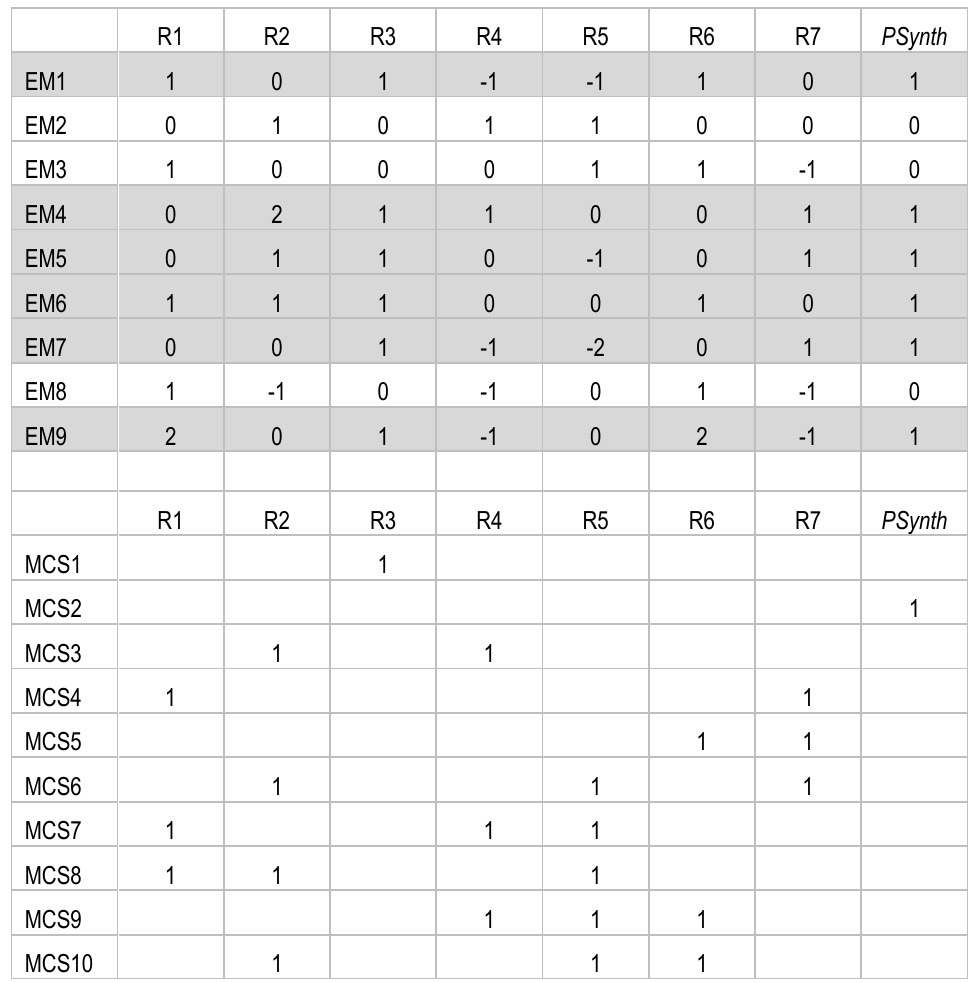
Table 4. EMs and MCSs of NetEx (all reactions are reversible): A zero in an EM row indicates that the corresponding reaction is not involved in the EM corresponding to that row; a ‘1’ in a MCS row indicates that the reaction in that column constitutes the MCS corresponding to that row, e.g., R3 constitutes